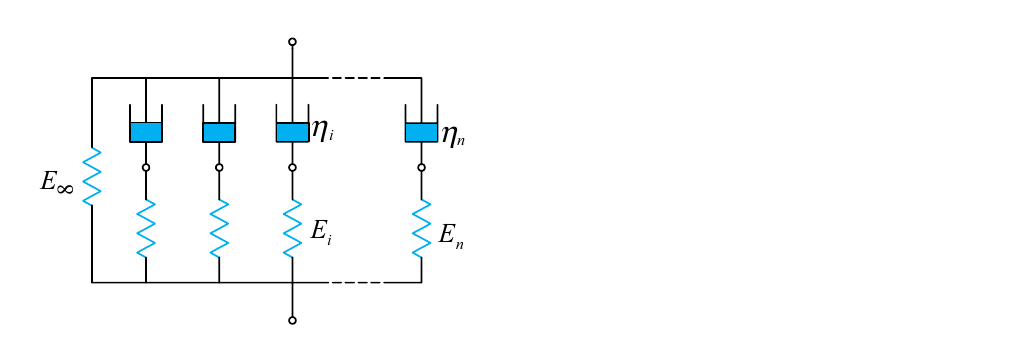
Figure 7. Schematic diagram of generalized Maxwell